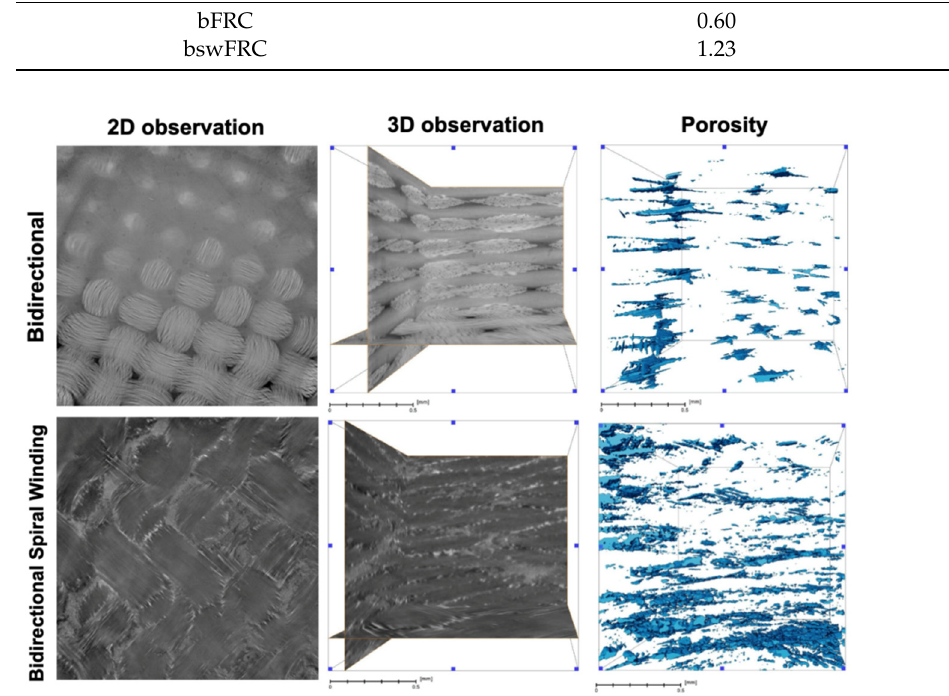
Figure 3. Volume rendering of the segmented pores (blue color) in bFRC and bswFRC, obtained by X-ray tomography analysis. The scale bar corresponds to 0.5 mm in all images. Table 2. Pore volume density (%) of bFRC and bswFRC as calculated from X-ray tomography im- aging.